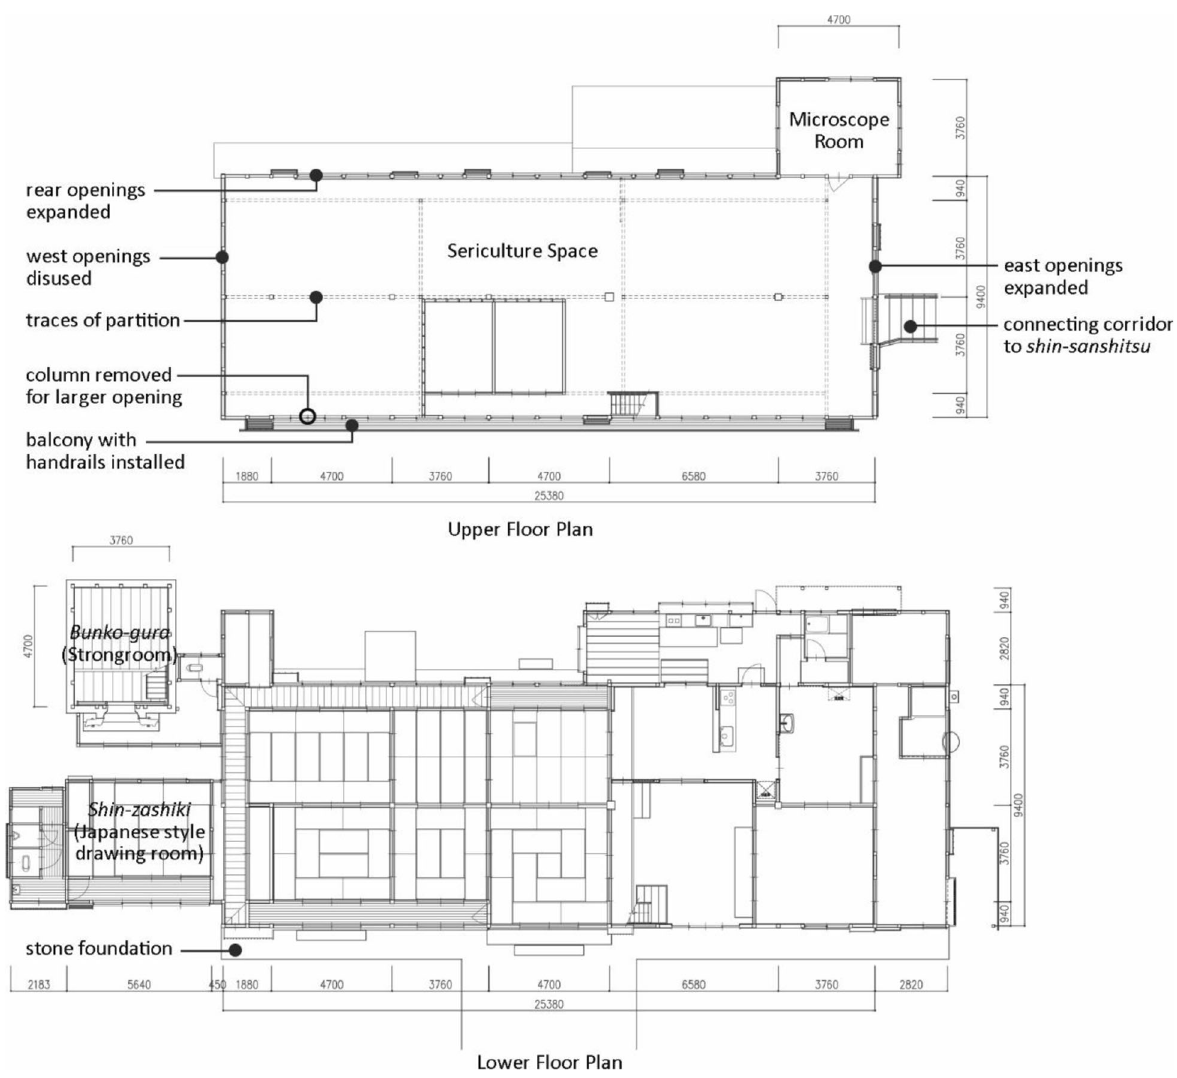
Fig. 5 Lower and upper floor plans of Tajima Yahei Sericulture Farm ’ s omoya . (Source: Agency for Cultural Affairs